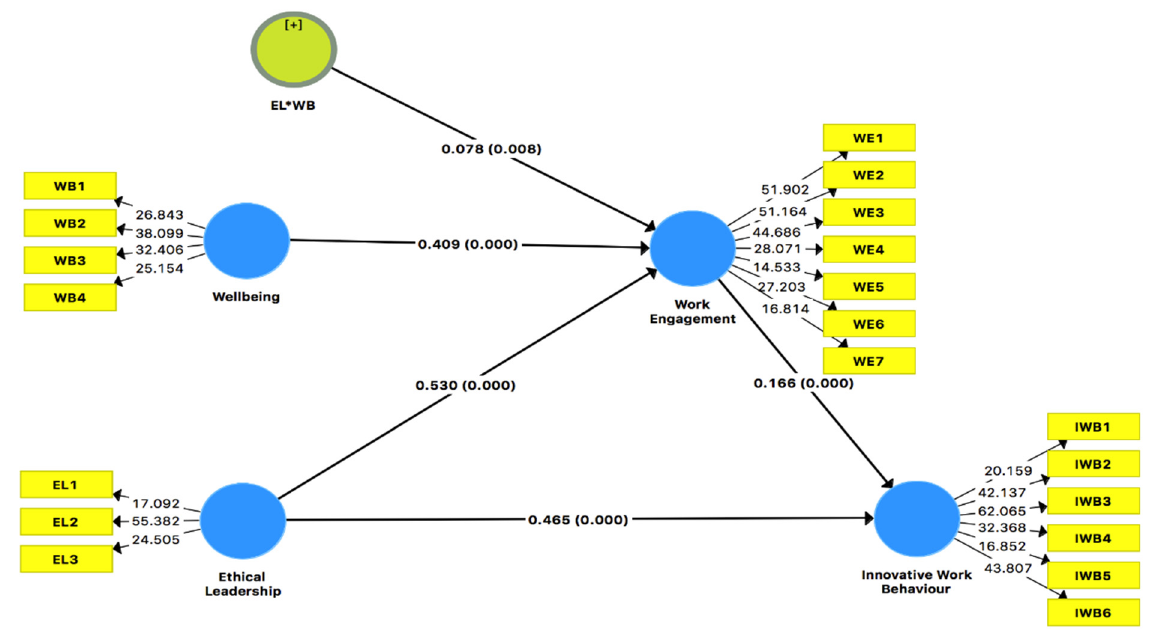
Figure 2. Path Analysis.